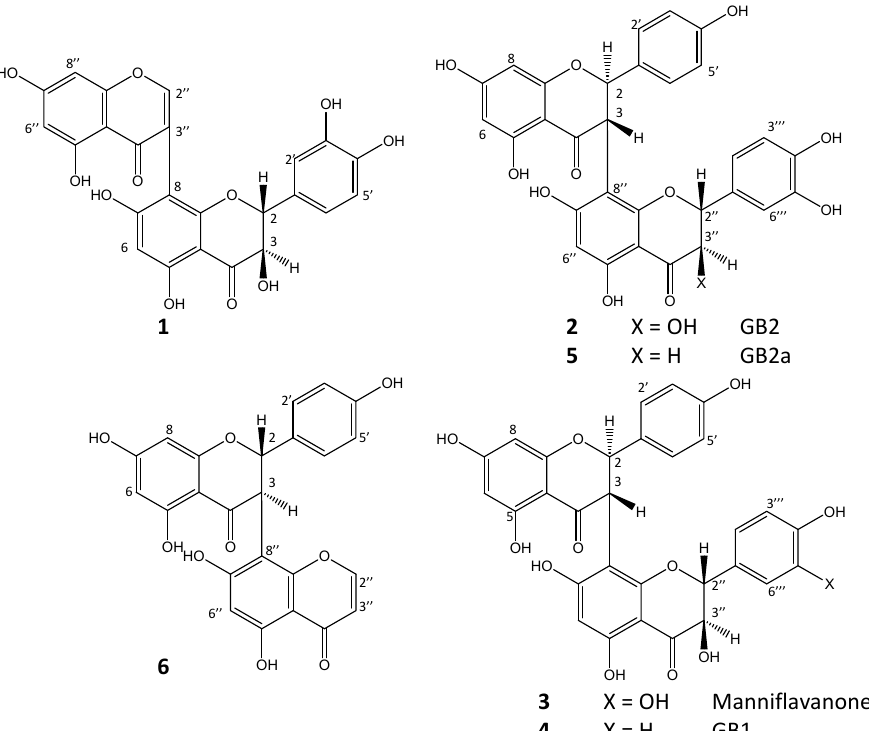
Figure 1. Chemical structures of compounds 1–6